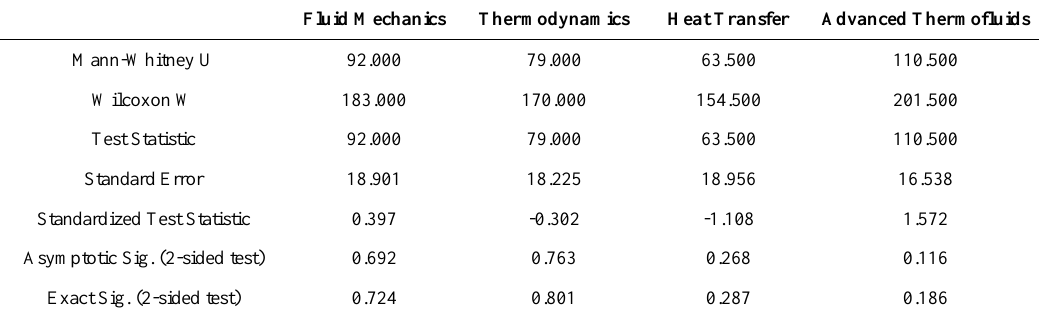
Table 1. Mann-Whitney U tests for academic performance of students in four